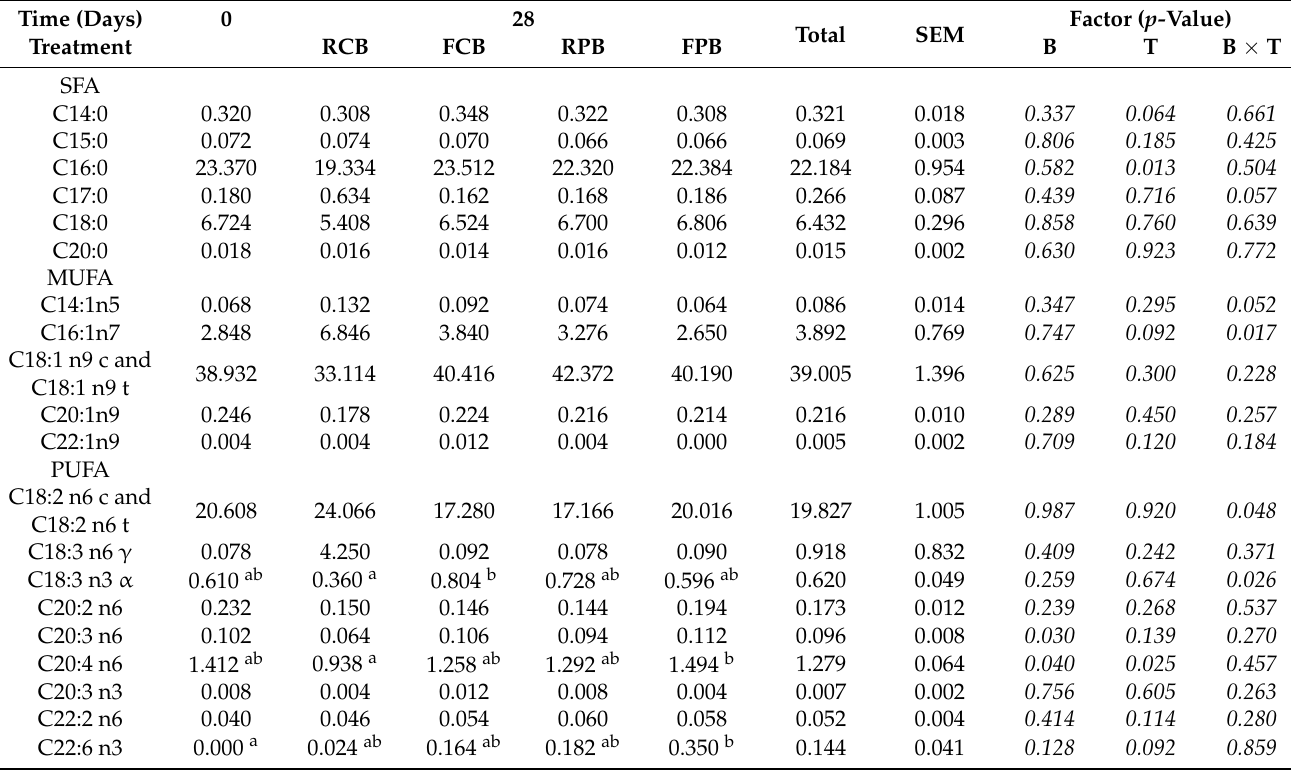
Table 5. Fatty acid profile of egg yolk in relation to packaging and storage temperature.